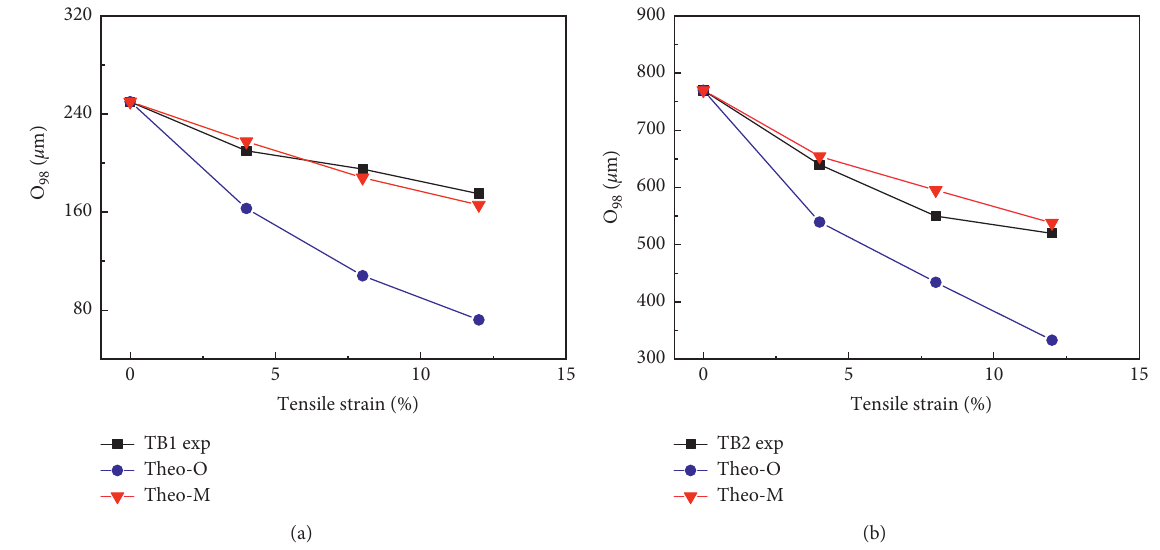
Figure 10: Experimental and theoretical O 98 of image analysis. (a) TB1. (b) TB2 (experimental O 98 sourced from reference